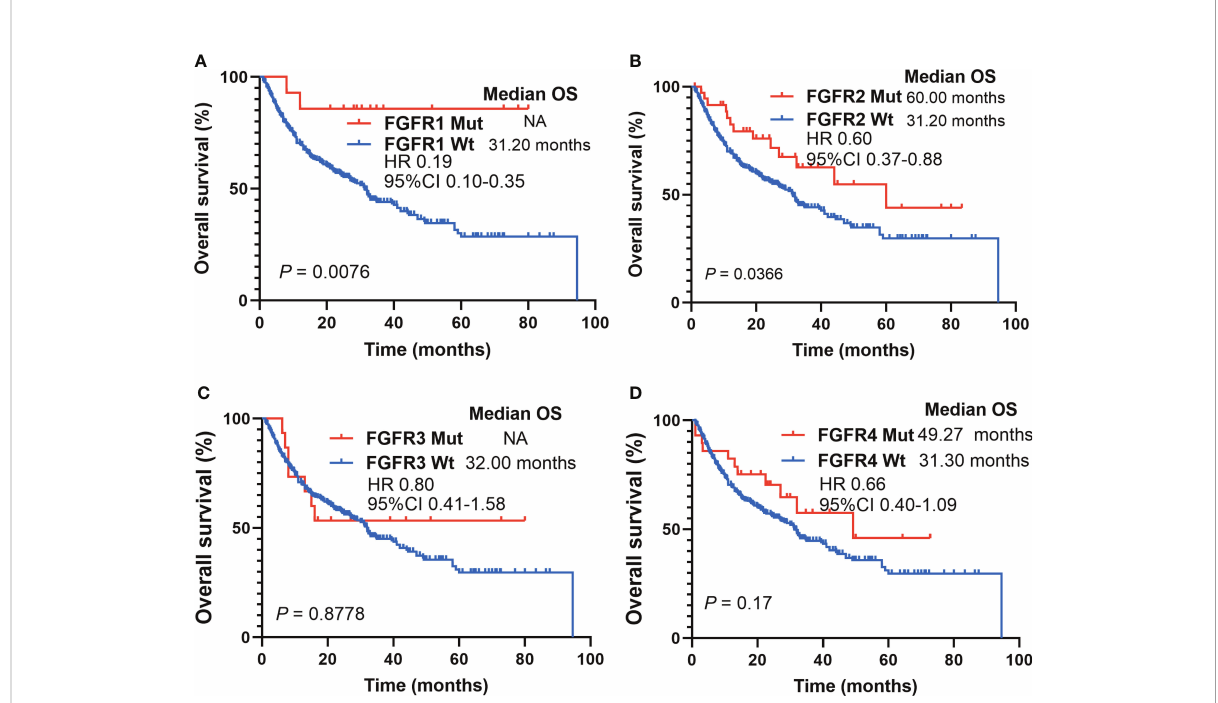
FIGURE 4 Survival analyses based on FGFR mutations subtypes in ICIs-cohort. (A) The Kaplan-Meier survival analysis comparing OS between FGFR1 Mut and FGFR1 Wt patients in ICIs-cohort. (B) The Kaplan-Meier survival analysis comparing OS between FGFR2 Mut and FGFR2 Wt patients in ICIs- cohort. (C) The Kaplan-Meier survival analysis comparing OS between FGFR3 Mut and FGFR3 Wt patients in ICIs-cohort. (D) The Kaplan-Meier survival analysis comparing OS between FGFR4 Mut and FGFR4 Wt patients in